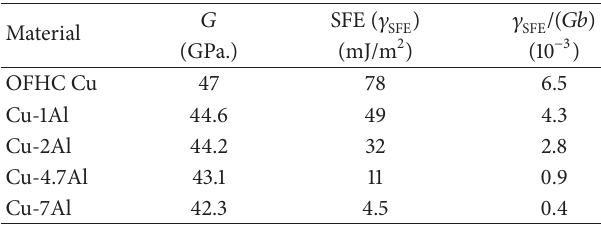
Table 1: Shear modulus ( 𝐺 ), stacking fault energy ( 𝛾 malized stacking fault energy 𝛾 burgers vector, for the materials used in this study [14, 15].